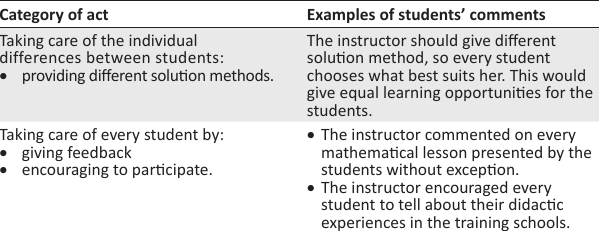
TABLE 7 : Didactic acts promoting equality. Category of act Examples of students’ comments